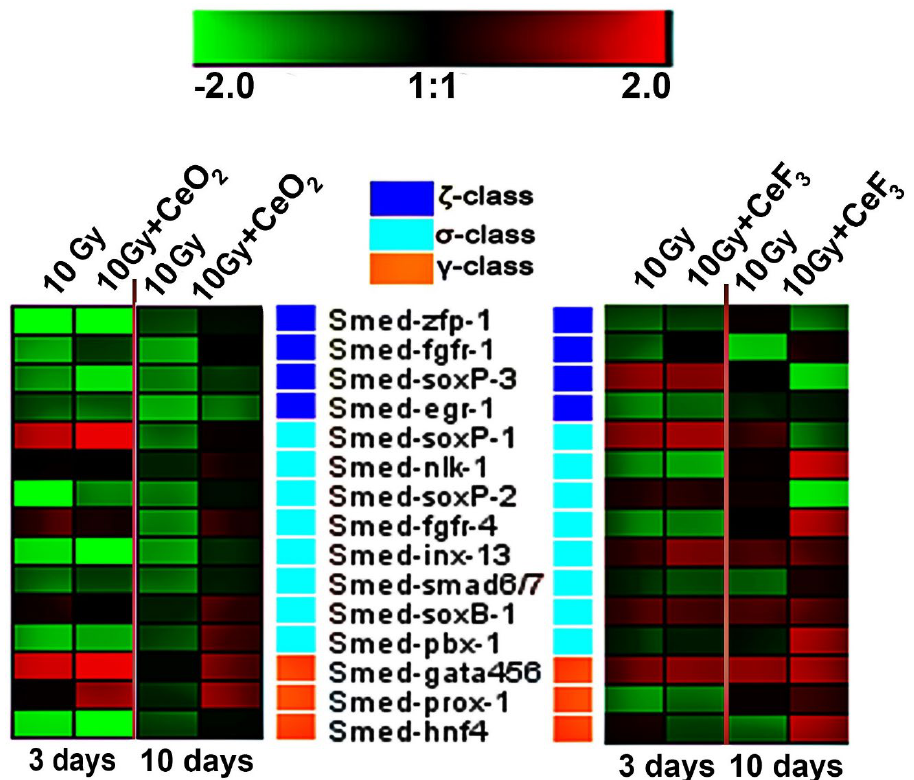
Figure 6. Expression of 3 classes of neoblast marker genes in regenerating planarians on days 3 and 10 after 10 Gy X-ray irradiation. The intensity scale of the standardized expression values ranges from − 2 (green: low expression) to +2 (red: high expression), with a 1:1 intensity value (black) representing the control (non-treated). The data in the heat maps are from the non-irradiated control group. A non-irradiated control group without CeO 2 or CeF 3 nanoparticle pretreatment was taken as a control.